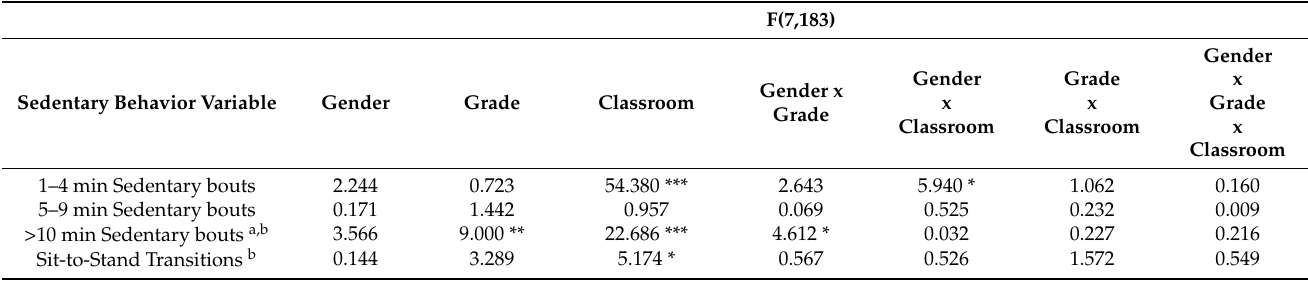
Table 2. Three-way ANOVA test of between-subjects effects of grade, gender and classroom type on sedentary behavior